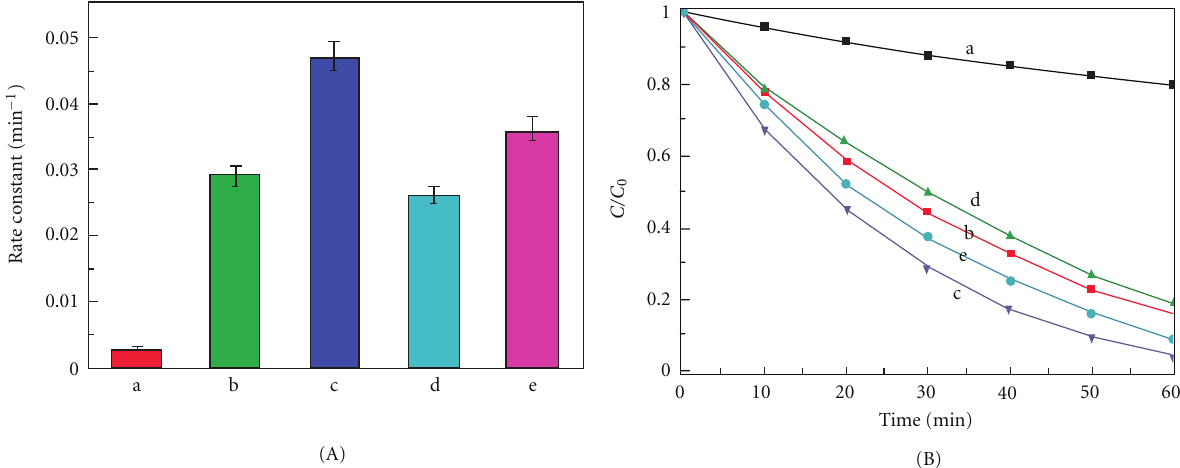
Figure 5: Comparison of photocatalytic activity of the TNs samples before and after treatment for the photocatalytic decomposition of MO in water: (a) untreated, (b) calcination, (c) vapor thermal, and (d) hydrothermal. (A) Apparent rate constants. (B) C/C 0 - t curve. C and C 0 denote the reaction and initial concentration of MO in the system, respectively